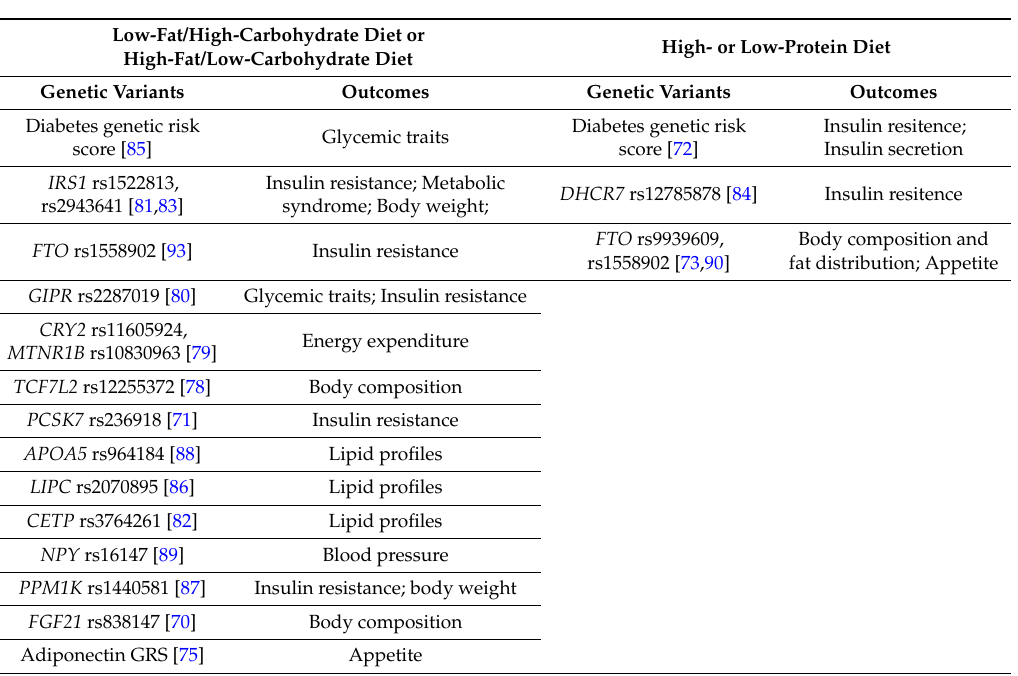
Table 2. Genetic variant that may alter effect of low-fat/high-carbohydrate and high-protein weight-loss diets on obesity and metabolic risk factors among overweight and obese